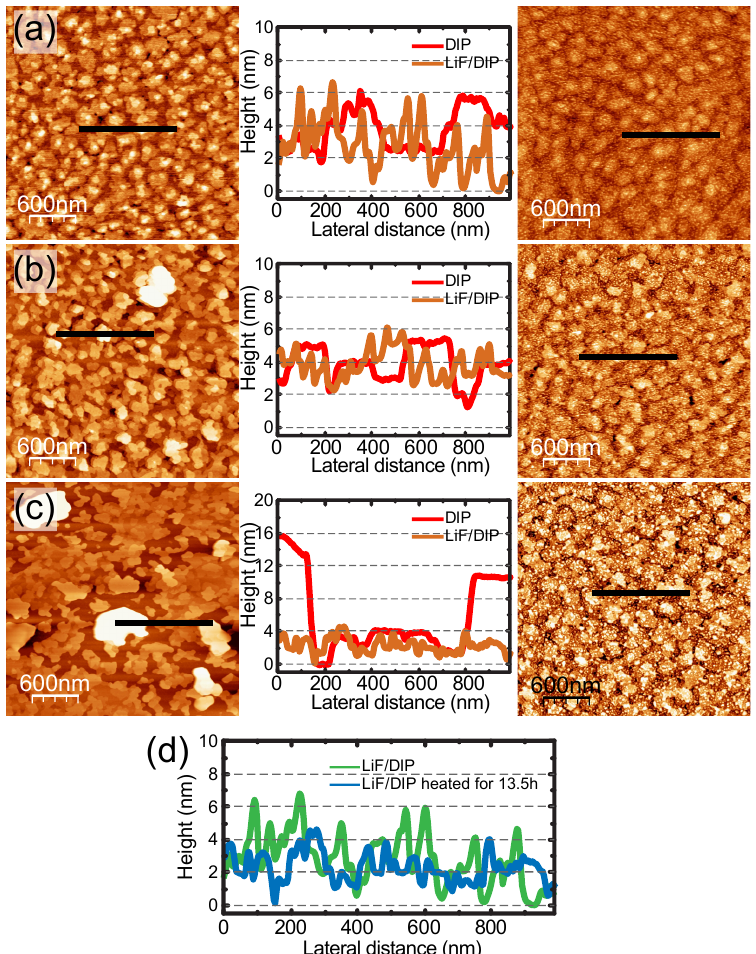
Figure 4. AFM micrographs of ( a ) the initial surfaces, ( b ) the surfaces after 9 h heating and ( c ) after 13.5 h heating at 90 °C of parallel-grown DIP (left) and LiF/DIP (right). The line profiles in the middle correspond to the lines in the AFM images. ( d ) Line profiles showing the comparison of LiF island heights before and after heating, corresponding to the lines indicated in the corresponding AFM images for the LiF/DIP